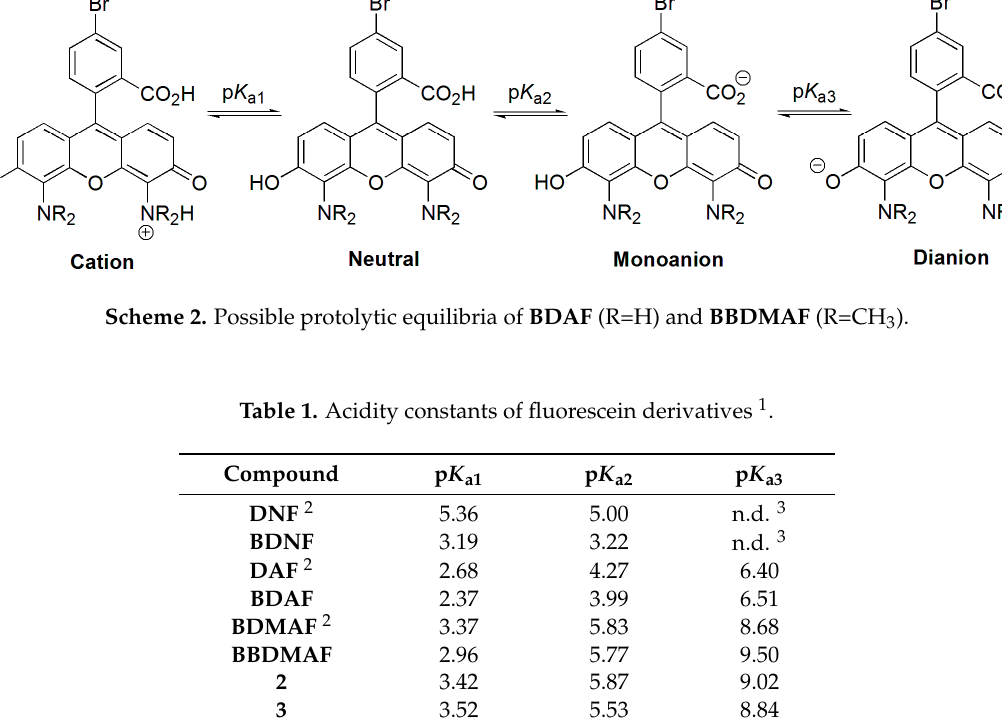
Figure 4. ( a ) Relative intensity of maximum emission of BBDMAF (515 nm) versus pH; each protolytic species was excited at its maximum absorption wavelength. ( b ) Emission image of BBDMAF solutions (concentration of each: 2.5 μ m) illuminated under a UV transilluminator (312 + 365 nm).